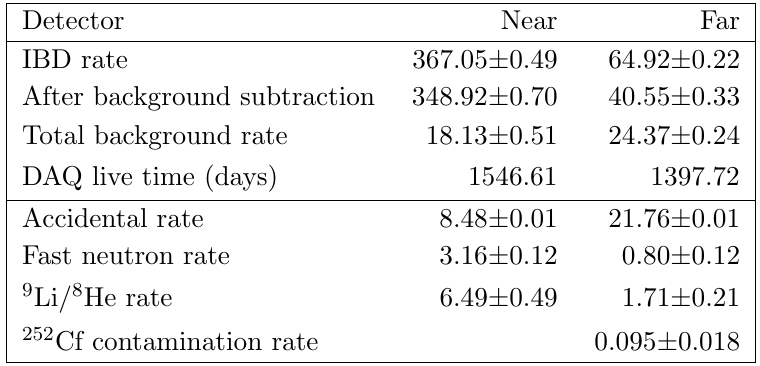
Table 3 . Observed rates of IBD candidates and remaining backgrounds per day for 1 : 2 < E p < 8 : 0